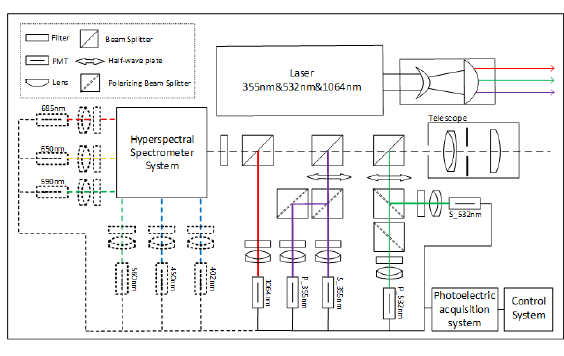
Fig 1. The LOOP system.